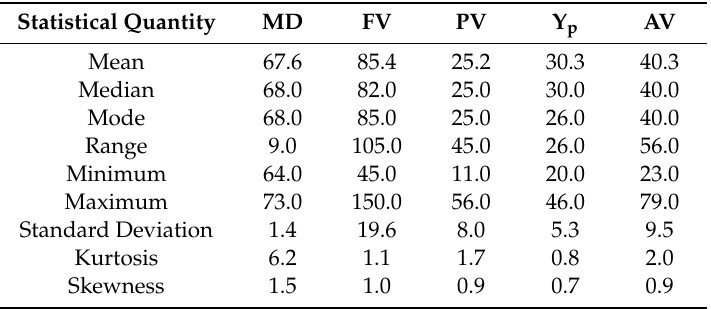
Table 3. Statistical analysis of the obtained data for HBM.